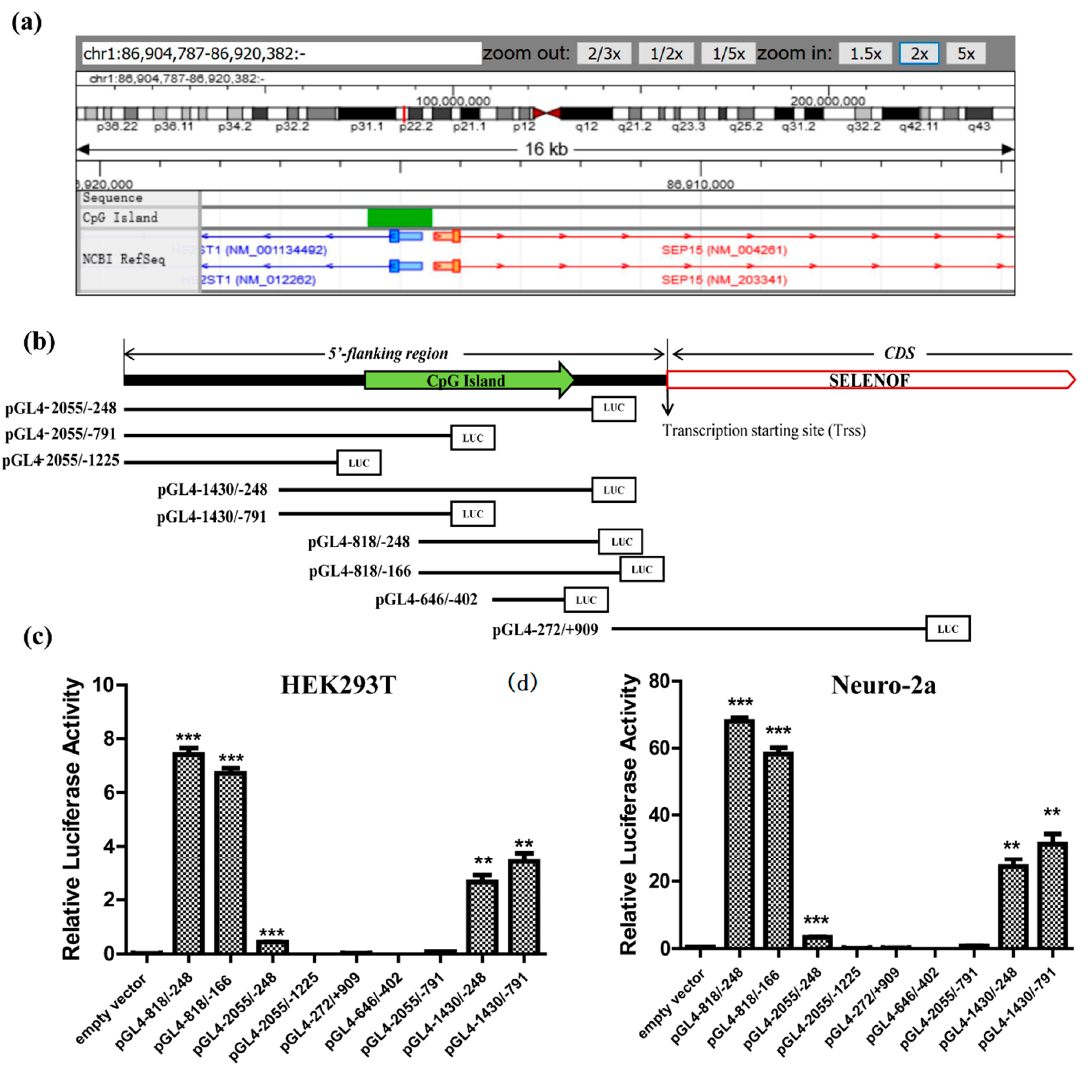
Figure 2. Identification of SELENOF regulatory elements. ( a ) Analysis of SELENOF (formerly known as SEP15) 5 (cid:48) -flanking regions in the Database of Transcriptional Start Sites (DBTSS). The SELENOF CDS was labeled with arrow and the CpG island was located up-stream of CDS. ( b ) Schematic locations of deletion derivatives designed for identification of SELENOF regulatory elements. Luciferase reporter activities of the deletion derivatives in HEK293T cells ( c ) and Neuro-2a cells ( d ). The empty vector pGL4.10 was used as the negative control. The data are representative of three independent experiments. * p < 0.05, ** p < 0.01 and *** p <